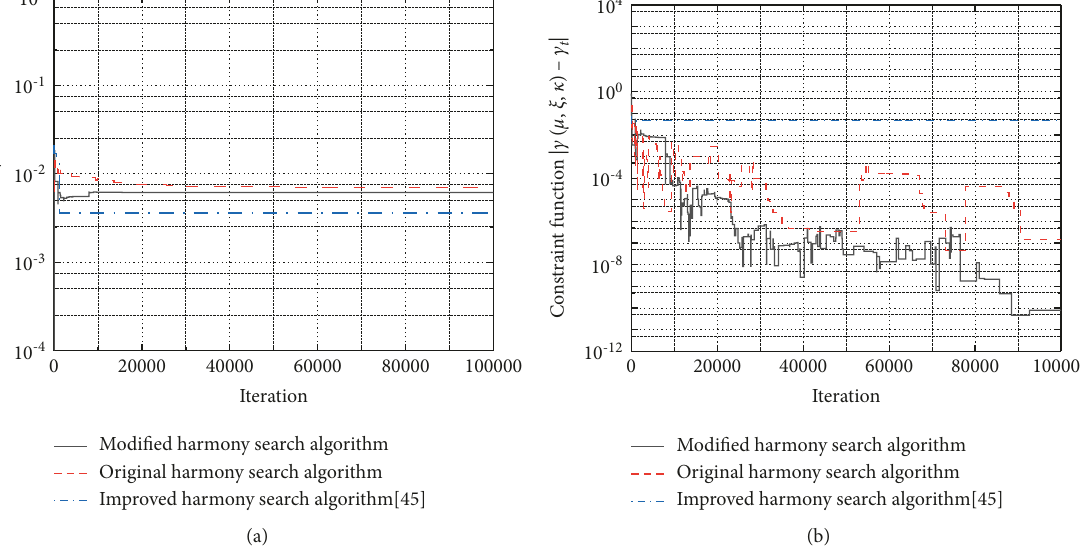
Figure 7: The variation trends of key indices during the optimization process for case 3. (a) The nominal damping ratio ξ . (b) The constraint function | c ( μ , ξ , κ ) − c t | .